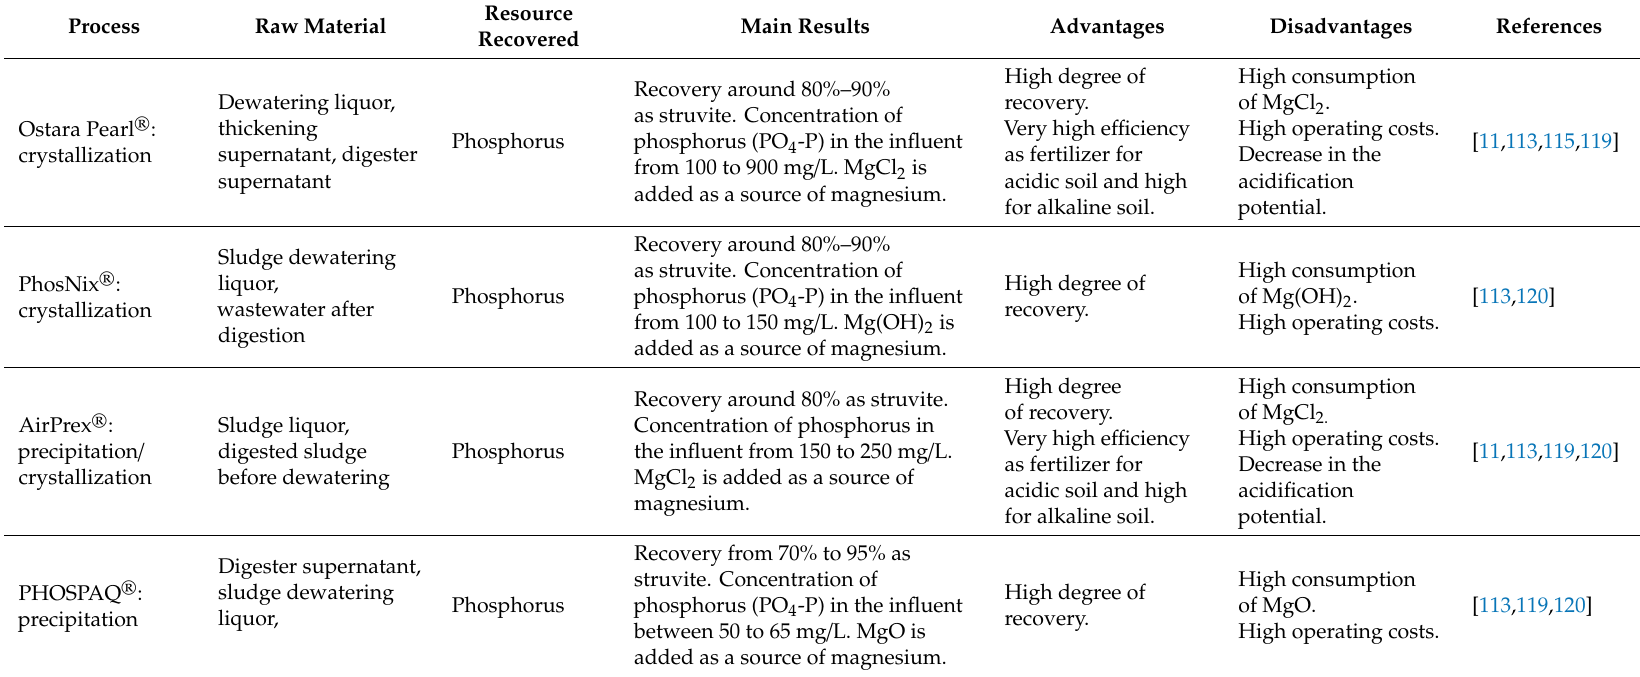
Table 4. Process employed for nutrient recovery from di ff erent wastewater